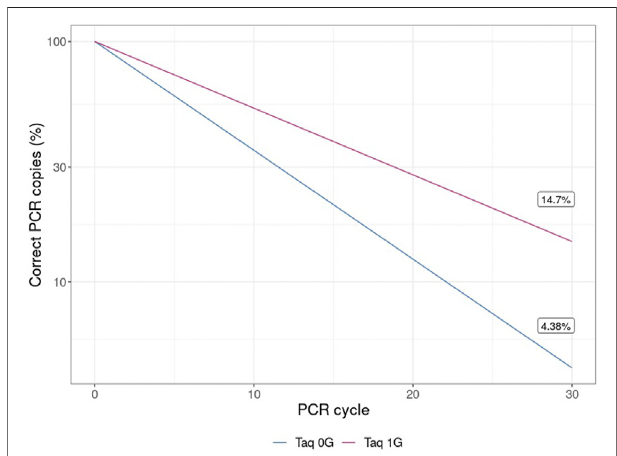
FIGURE 8 | Percentage of templates containing errors over 30 cycles of PCR with Taq polymerase. The theoretical decreased fi delity due to PCR was calculated based on mean increase in error rate from either earth-like gravity (1 G) or microgravity ( μ G) and adjusted based on the documented error rate for Taq